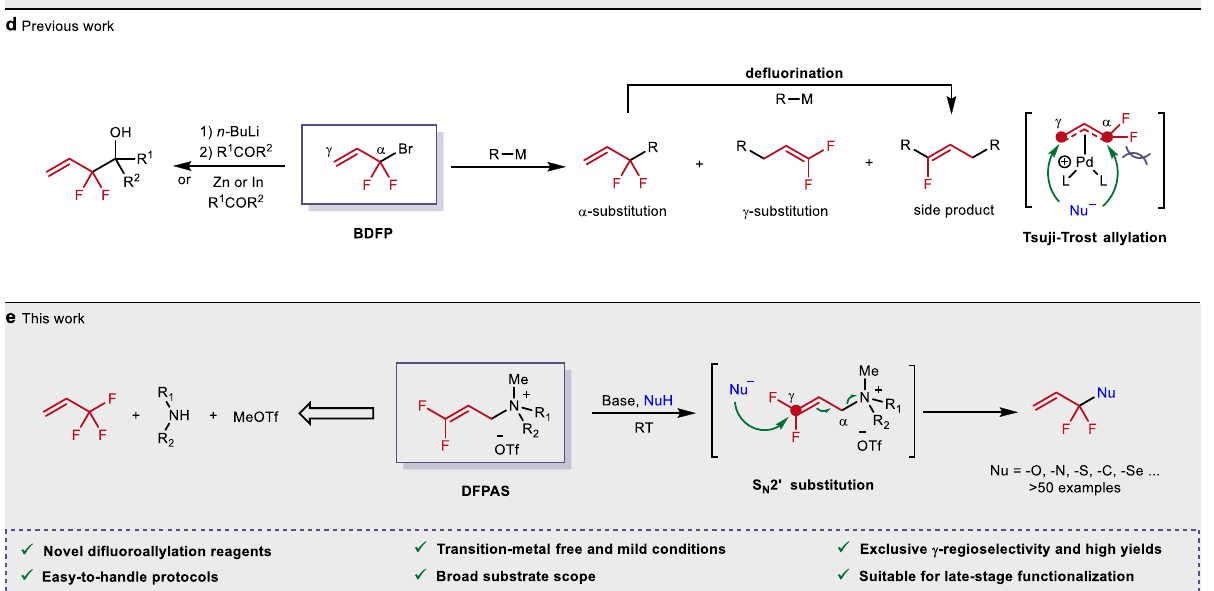
Fig. 1 The allure of fl uoroalkylations. a The dynamic development of fl uoroalkylations in the past years. b Commonly used fl uoroalkyl-containing reagents for direct preparation of fl uoroalkyl compounds. c The importance of compounds containing di fl uoromethylene unit. d The challenge of the direct preparation of gem -di fl uoroallyl compounds using BDFP. e The presented strategy for the selective construction of gem -di fl uoroallyl